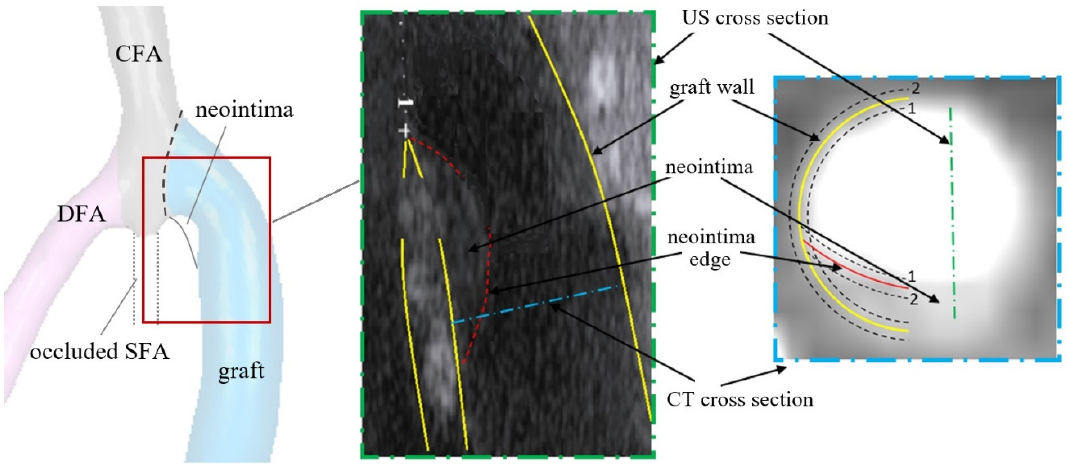
Figure 3. Scheme to the approach used for determination of the graft (yellow line) and neointima (red line) edges using MSCT and US images. The common femoral artery (CFA) is marked in gray, the graft in blue, the deep femoral artery (DFA) in pink and neointima in dark gray. Auxiliary curves are marked as 1 and 2. Table 1. Parameters of the considered models.